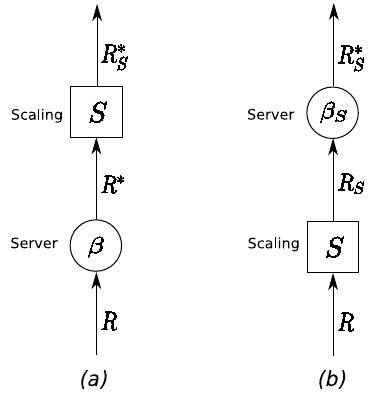
Figure 4. Alternative